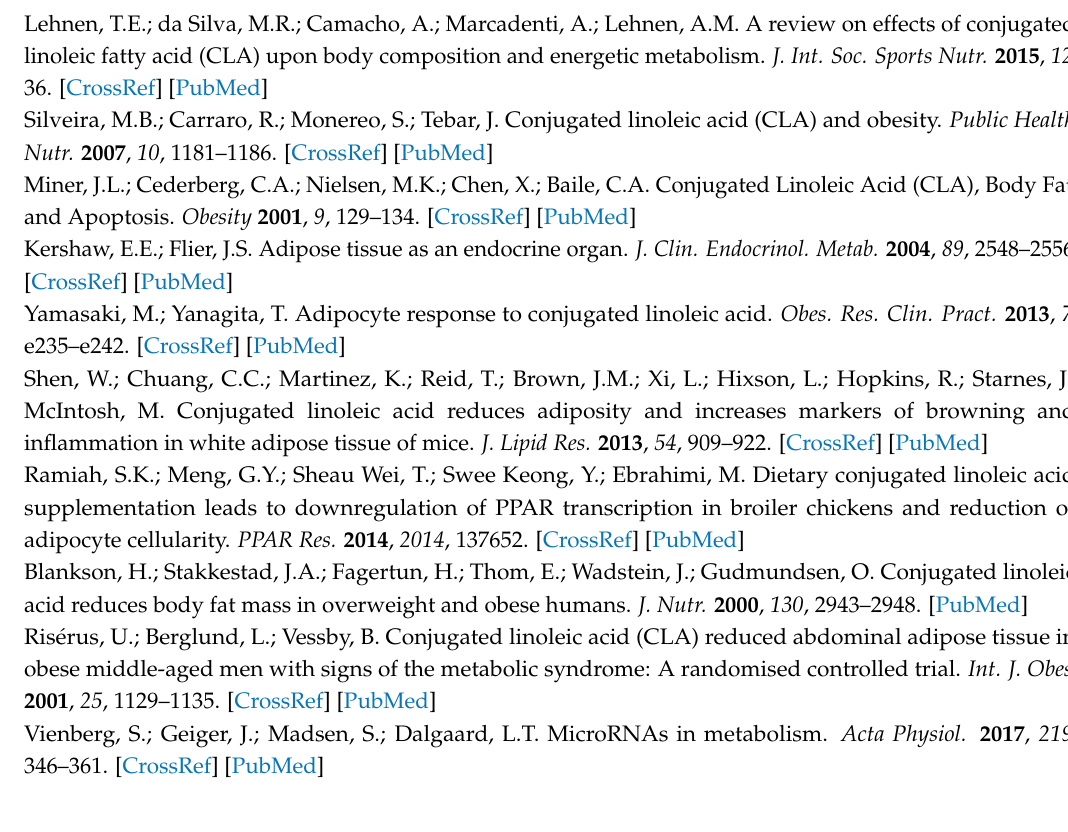
Figure S1: Small RNAs annotation; Figure S2: GO categories and distribution of 14 DE miRNA targets in pigs; Figure S3: The Wnt signalling pathway enriched by putative target genes of 14 DE miRNAs. Red boxes represent the target genes of miRNAs; Table S1: Composition of the basal diets for sows at different periods; Table S2: Datasets used in the study; Table S3: Primers used in this study; Table S4: The percentage of miRNA based on their length; Table S5: Predicted chromosomal positions, sequences, dominant arm, hairpin structure, minimum free energy, and counts of new miRNAs; Table S6: Information of known porcine miRNAs; Table S7: The read counts of all known porcine miRNAs; Table S8: Effects of CLA on body weight and fat deposition of pigs; Table S9: The information of log2 fold change for 14 DE miRNAs at each period; Table S10: The information of log2 fold change and FDR for new miRNAs; Table S11: KEGG pathways enriched for target genes of 14 DE miRNAs between control and CLA group. Supplemental File S1: RNA-seq data generated in this